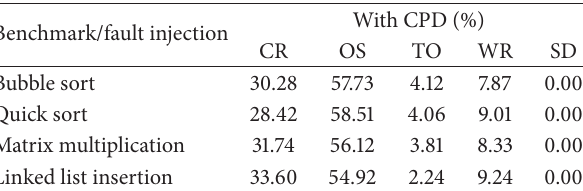
Table 6: Fault injection results on kernel components with CPD on Core